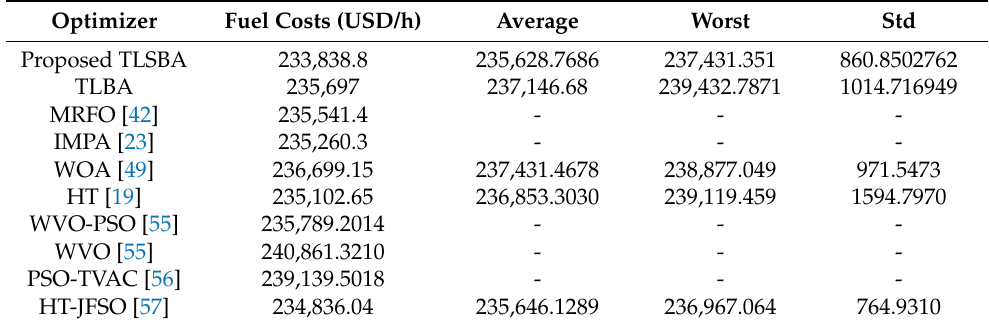
Table 9. Comparison of TLSBA, TLBA and reported techniques for test system